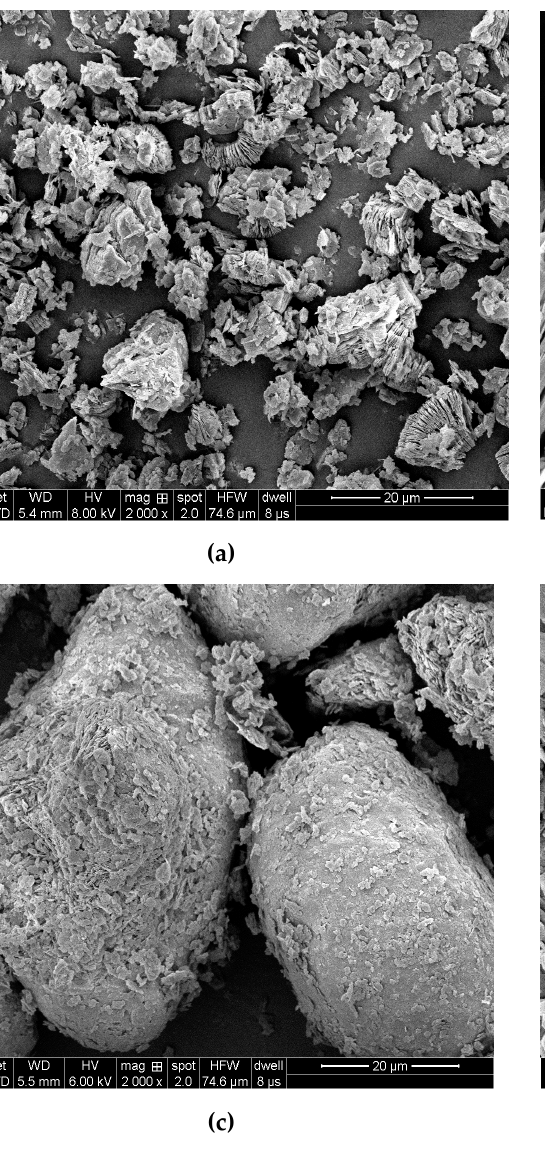
Figure 4. Field emission scanning electron microscopy (FESEM) images of Wenchang kaolin ( a , b ) and Maoming kaolin ( c , d ).